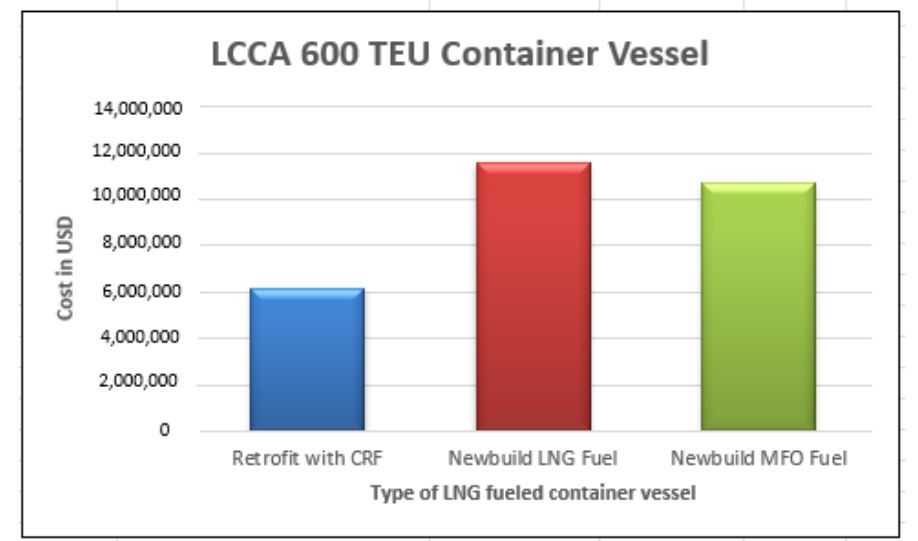
Figure 15. LCCA 600 TEU container .